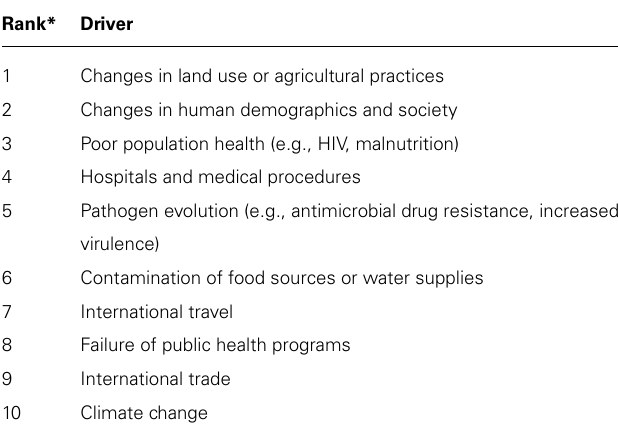
Table 1 | Main categories of factors associated to the emergence and re-emergence of human pathogens. Seventy-five percent of them are zoonotic (from Woolhouse and Gowtage-Sequeria,